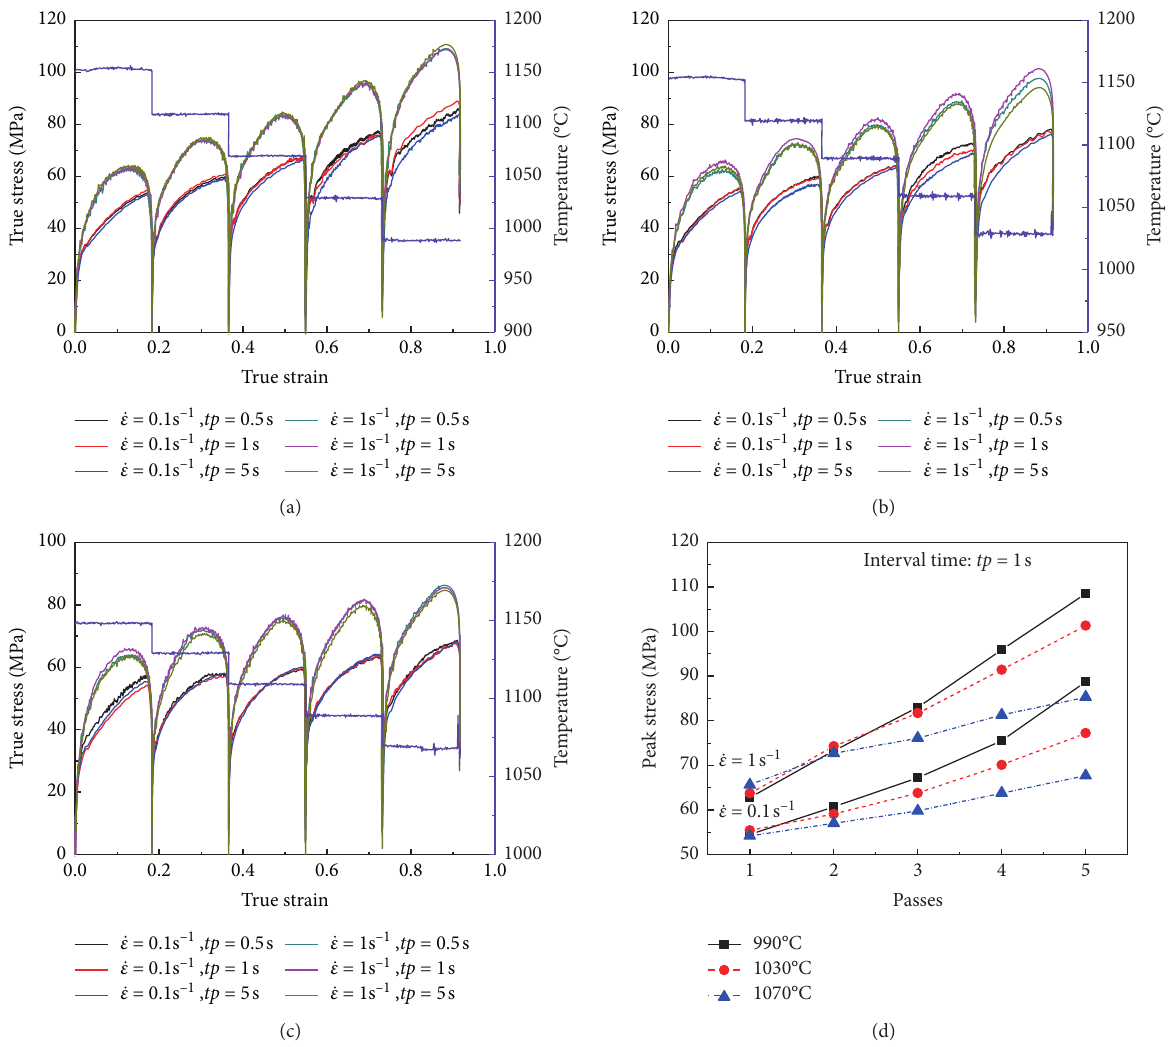
Figure 3: True stress-strain curves of as-cast 42CrMo alloy at different finishing temperatures of (a) 990 ° C, (b) 1030 ° C, (c) 1070 ° C, and (d) peak stress of each pass during nonisothermal multipass